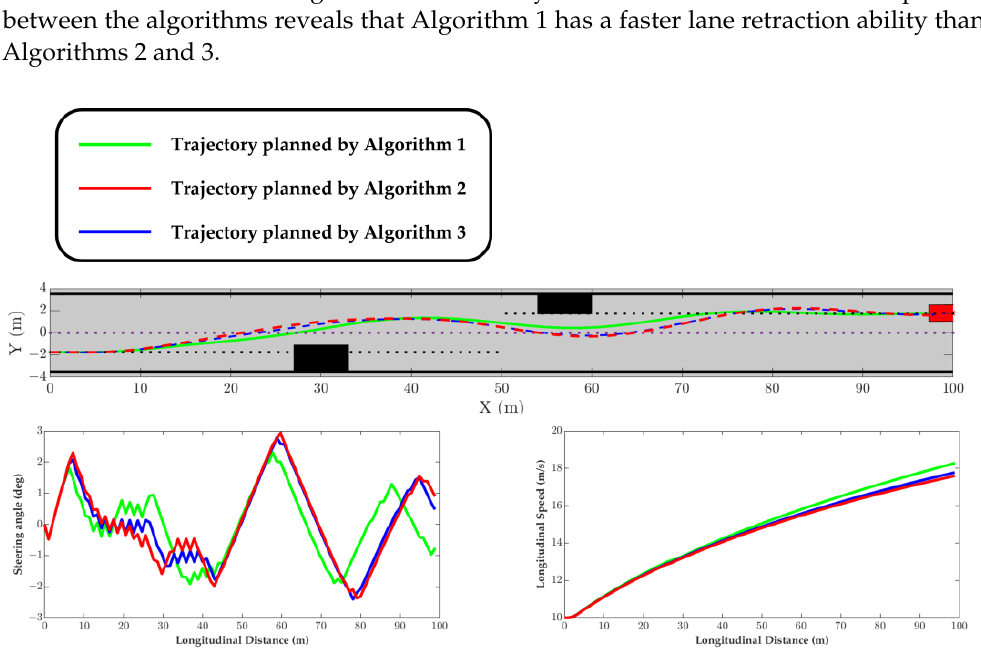
Figure 4. The results of Experiment 1.